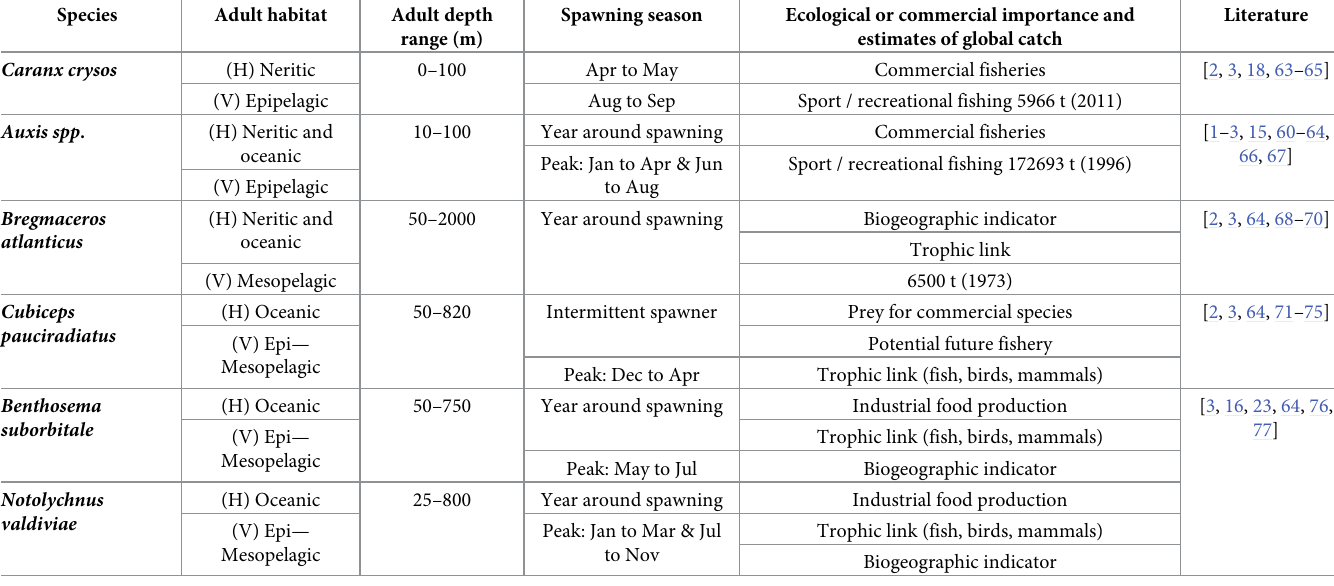
Table 2. Species selected for GAM analysis, according to ecological and life history characteristics and/or commercial importance.